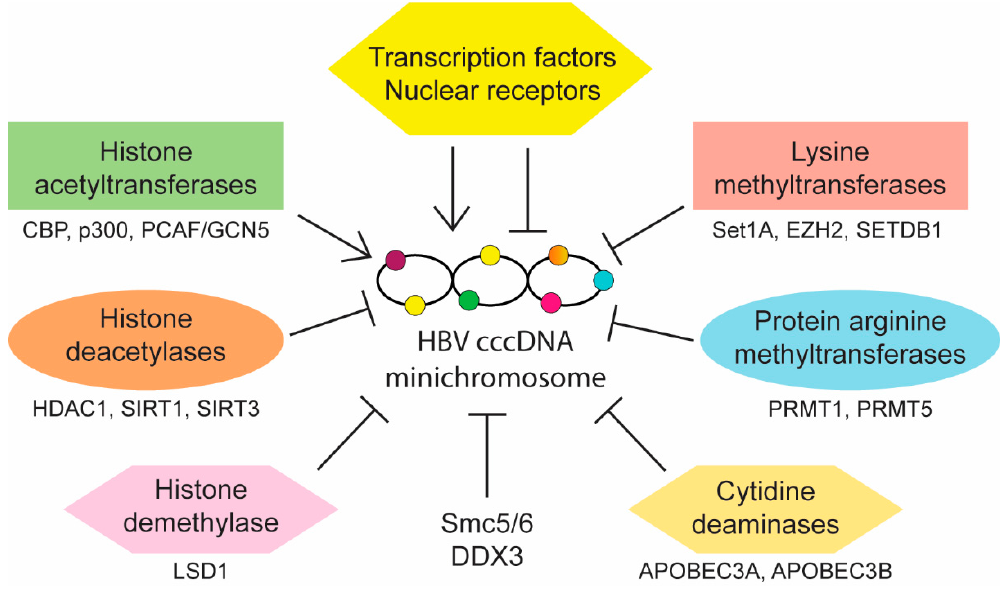
Figure 2. Summary of main classes of host factors that promote or inhibit covalently closed circular DNA (cccDNA)